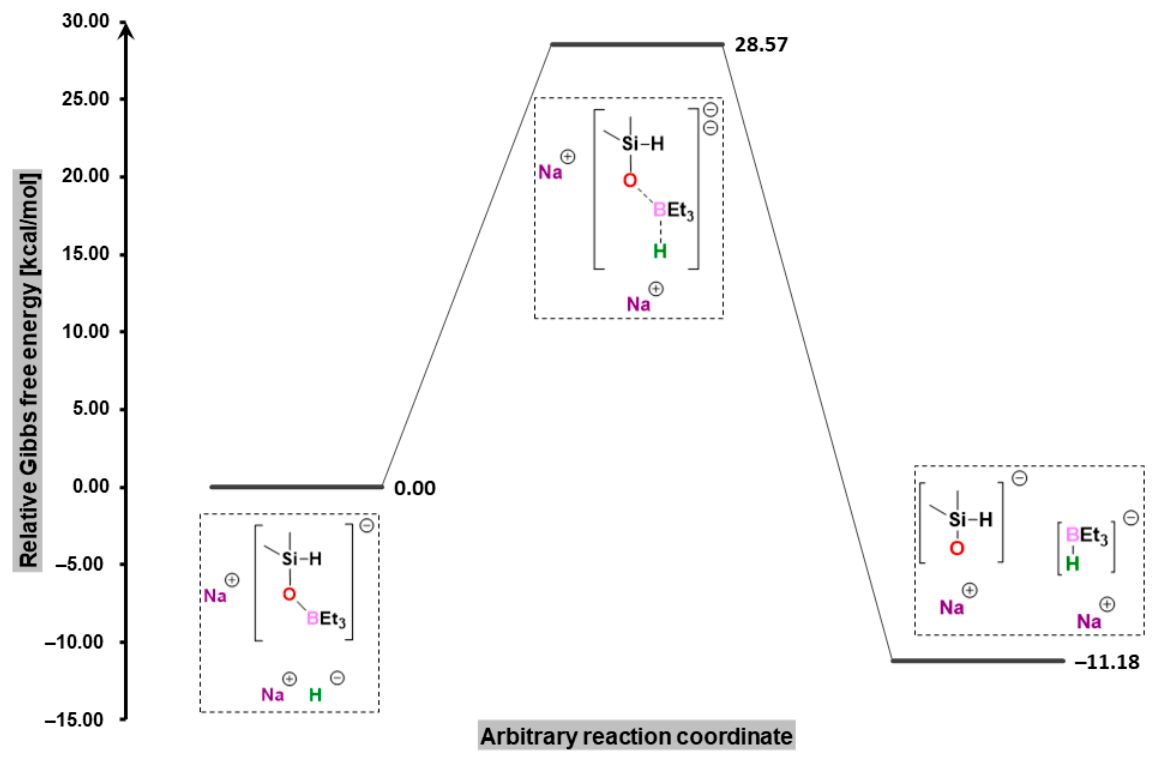
Figure 6. Free-energy profile for the reaction of the borasiloxyl salt with sodium hydride, leading to sodium trialkylborohydride regeneration.